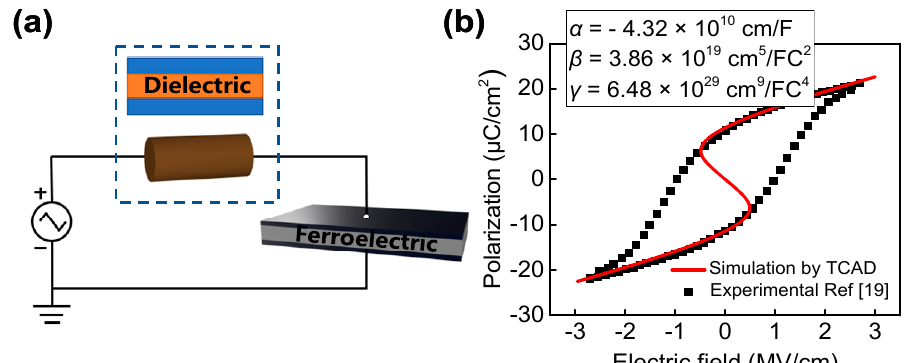
Figure 2. ( a ) Negative capacitance measurement circuit, ( b ) comparison between simulated P–E curve with experimental results for Si: HfO 2 [19].